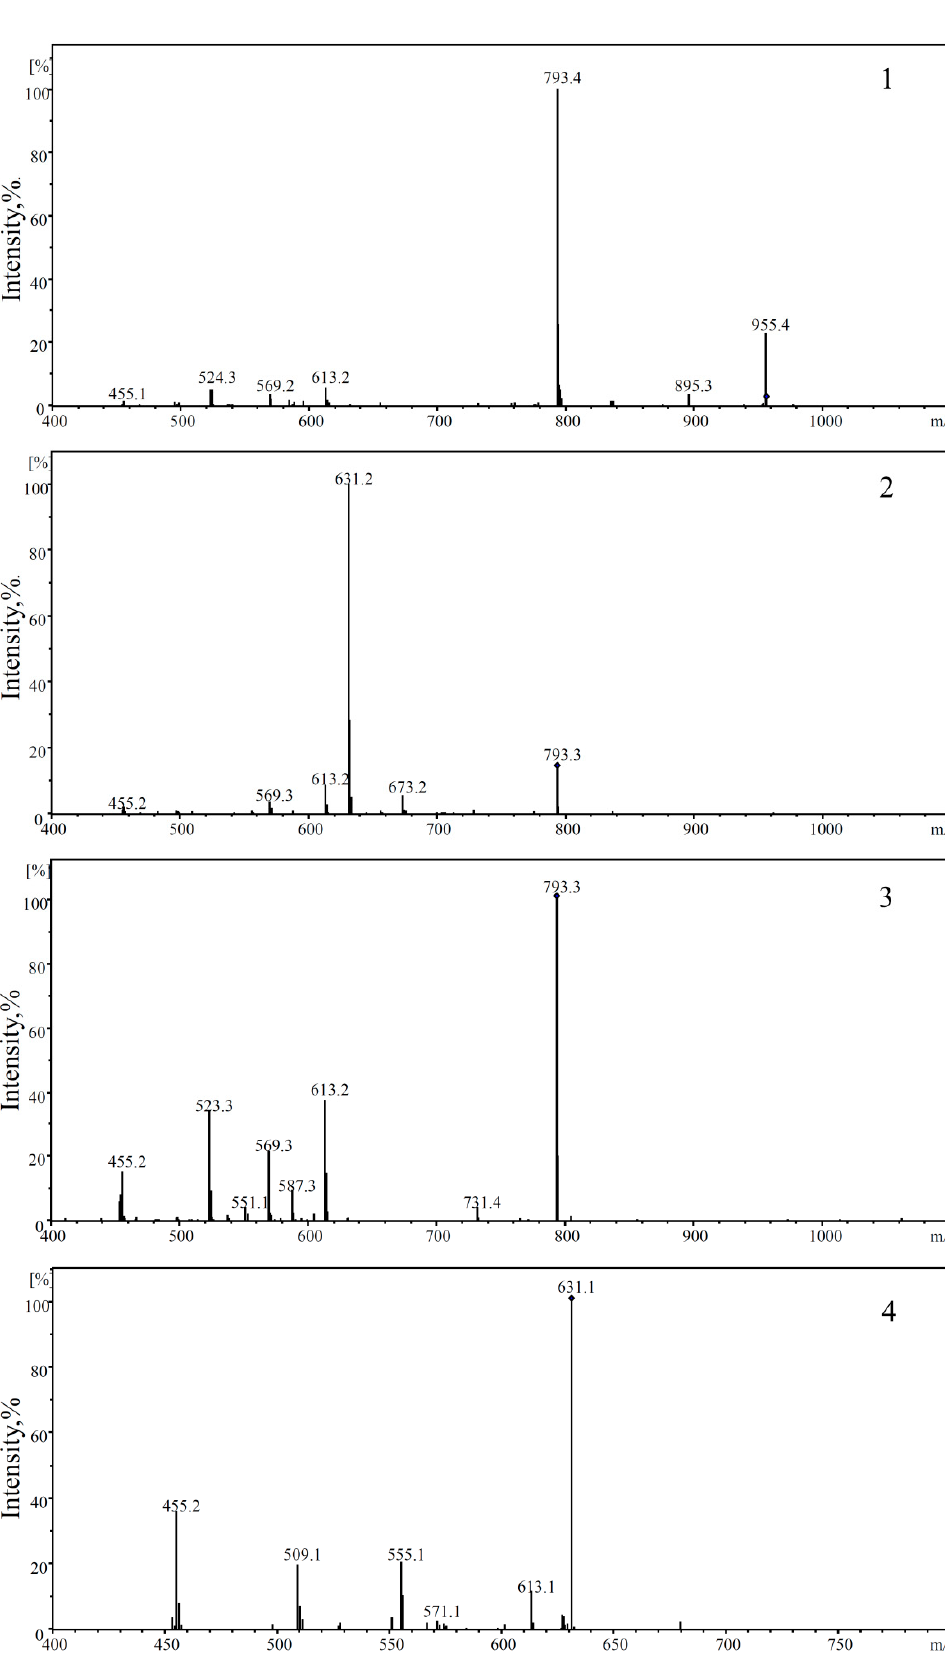
Figure 4. Negative collision-induced dissociation (CID) spectrum of compounds 1 – 4 . (1) Ro: ginsenoside Ro; (2) IVa: chikusetsusaponin IVa; (3) R1: zingibroside R1; (4) E: calenduloside E.